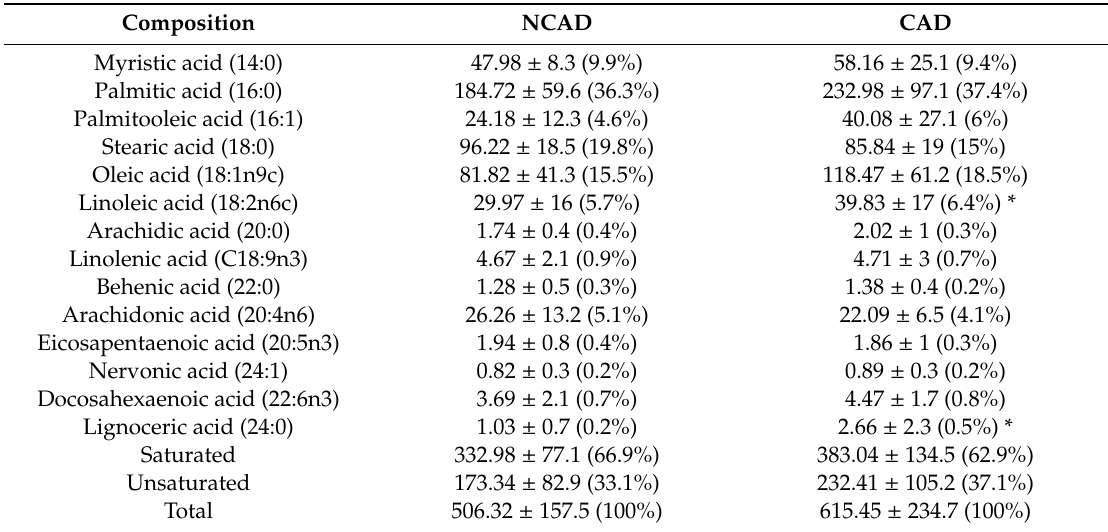
Table 3. DG—Fatty acid composition (nmol / g of wet tissue).